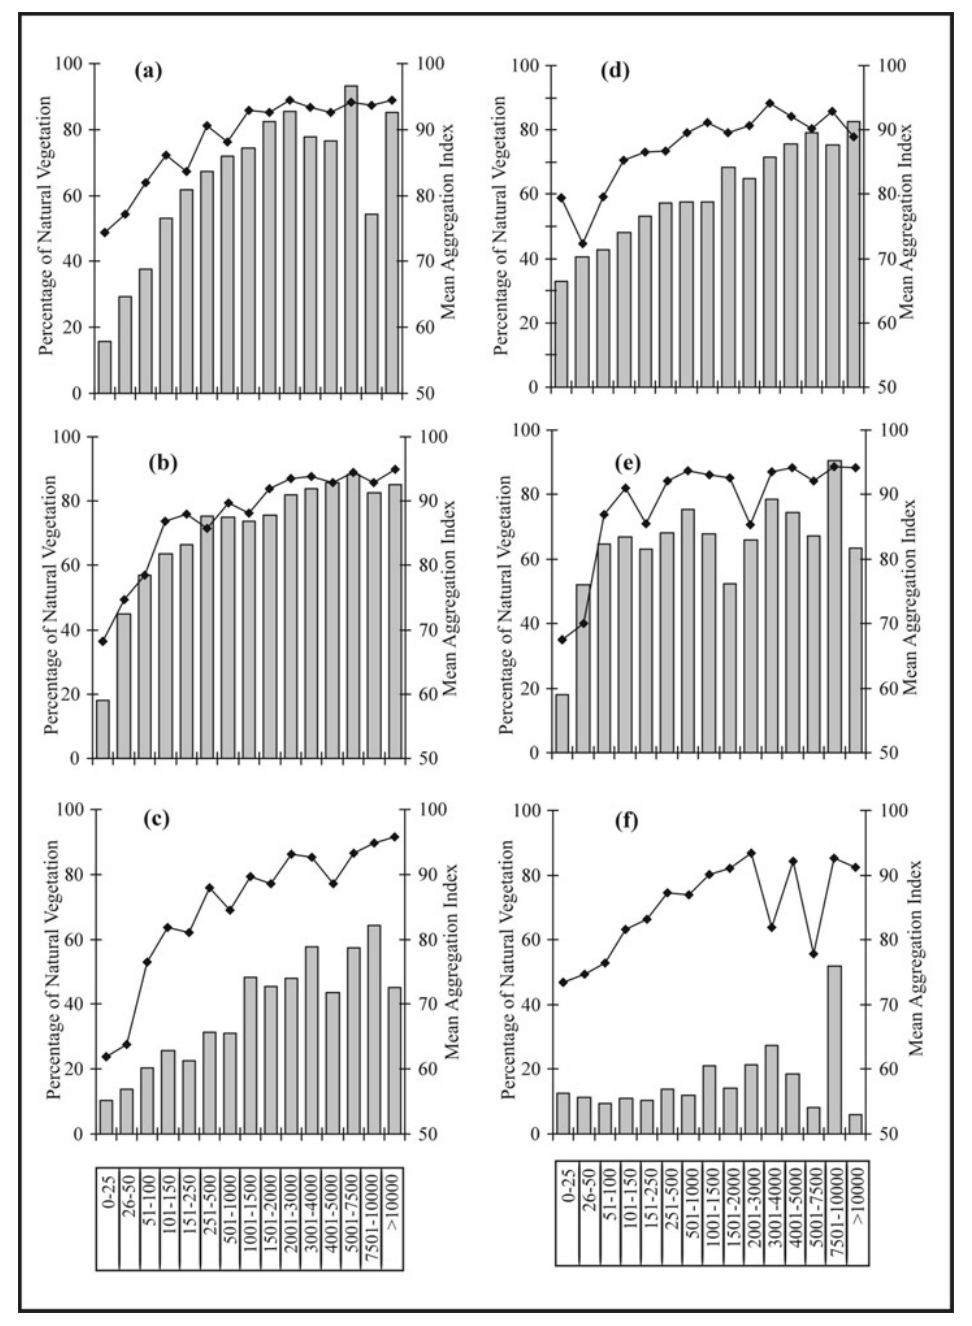
Fig. 5. Aggregation Index (AI, diamond symbol) and percentage of natural vegetation (PNV, bars) by parcel size, in six subregions; a) Gran Sierra Plegada, b) Llanuras Occidentales , c) Tamaulipas Plains and Hills, d) K arst Huasteco, e) Sierra de Tamaulipas, and f) Veracruz Plains and Hill. Parcel size intervals (x-axis) are shown at the